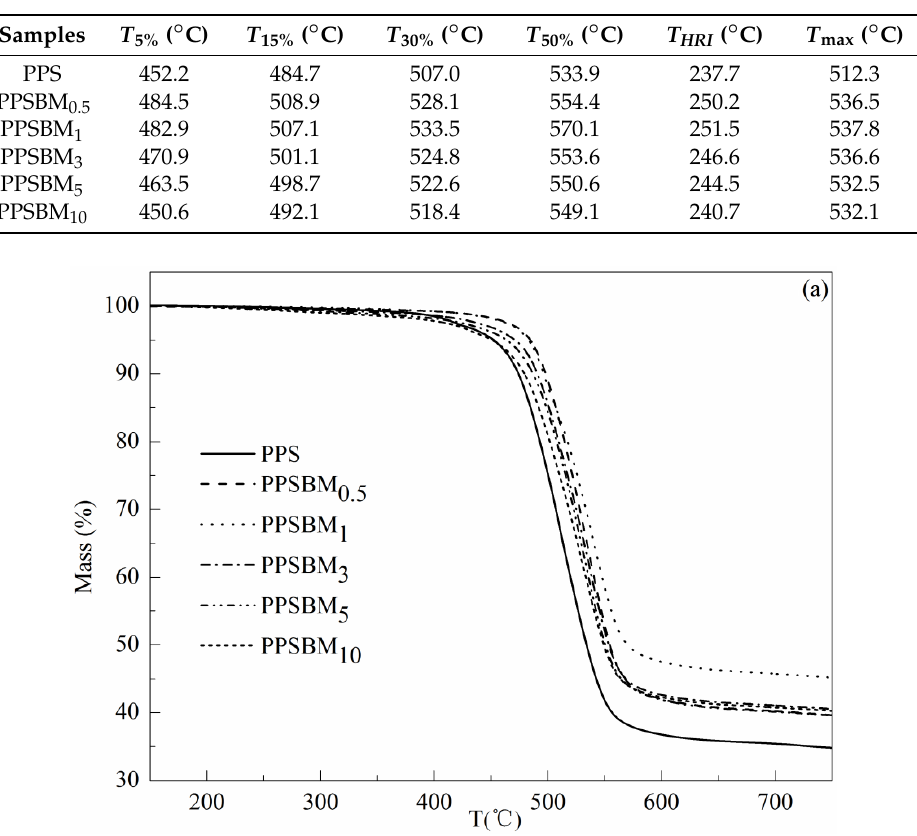
Table 1. TGA parameters of PPS and PPSBM x composites.